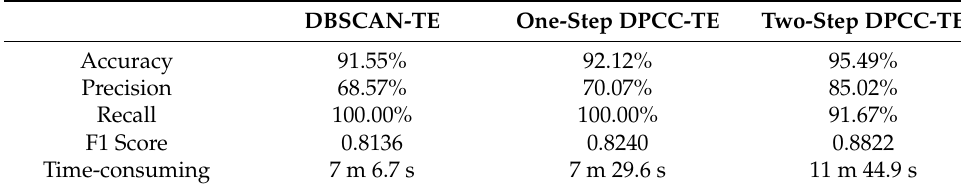
Table 2. Comparison of different